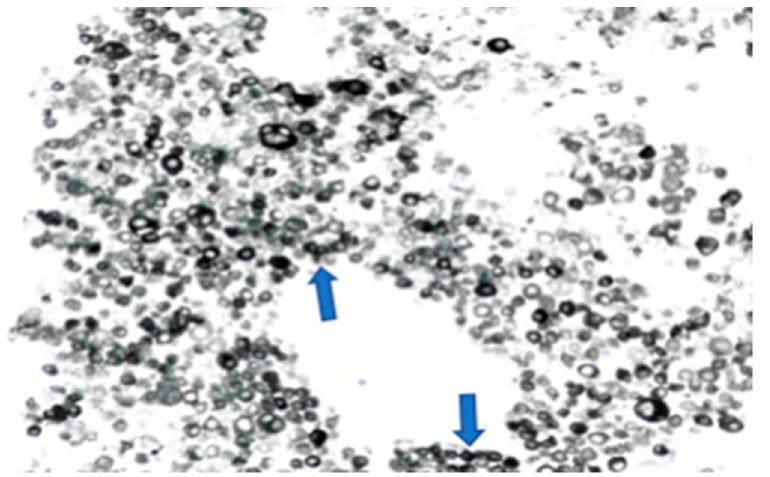
Figure 4. Melanoma cells (numerous dark circle-like cells, melan A staining) on the left groin core biopsy.